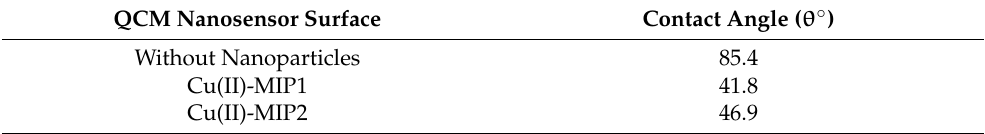
Figure 4. Contact angle snapshots of Cu(II)-MIP1 ( a ) and Cu(II)-MIP2 ( b ) nanoparticles. Table 2. Contact angles of QCM nanosensor